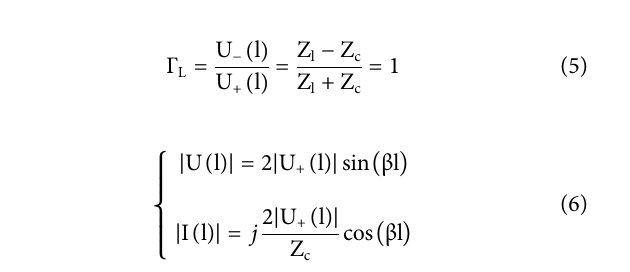
Frontiers in Physics |